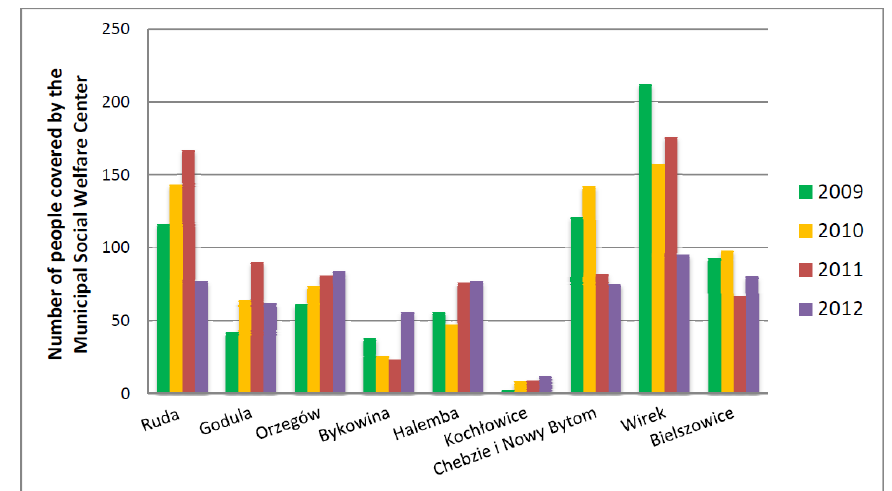
Fig. 4. Number of persons covered by the Social Welfare Centre (MOPS) for alcoholism in different districts of Ruda Śląska (own study, by